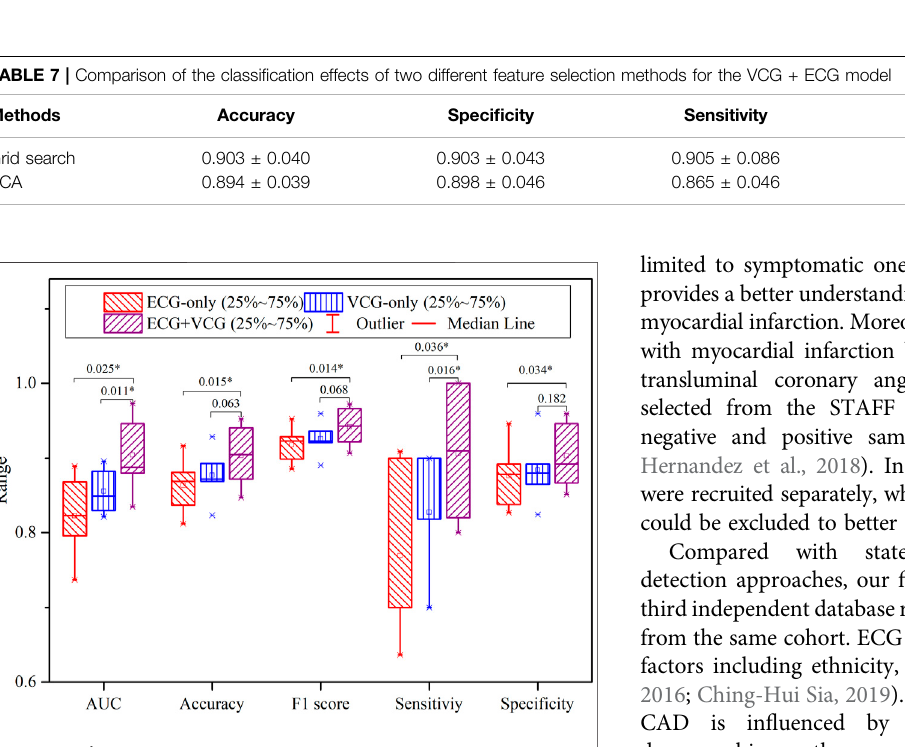
FIGURE 7 | The boxplots of the accuracy, speci fi city, sensitivity, F1 score, and AUC for myocardial ischemia detection correspond to the ECG- only, VCG-only, and ECG + VCG